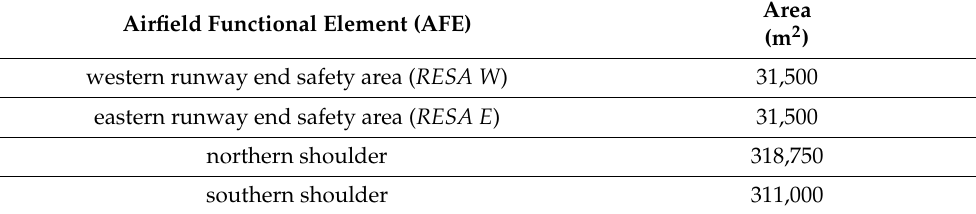
Table 6. Summary of the